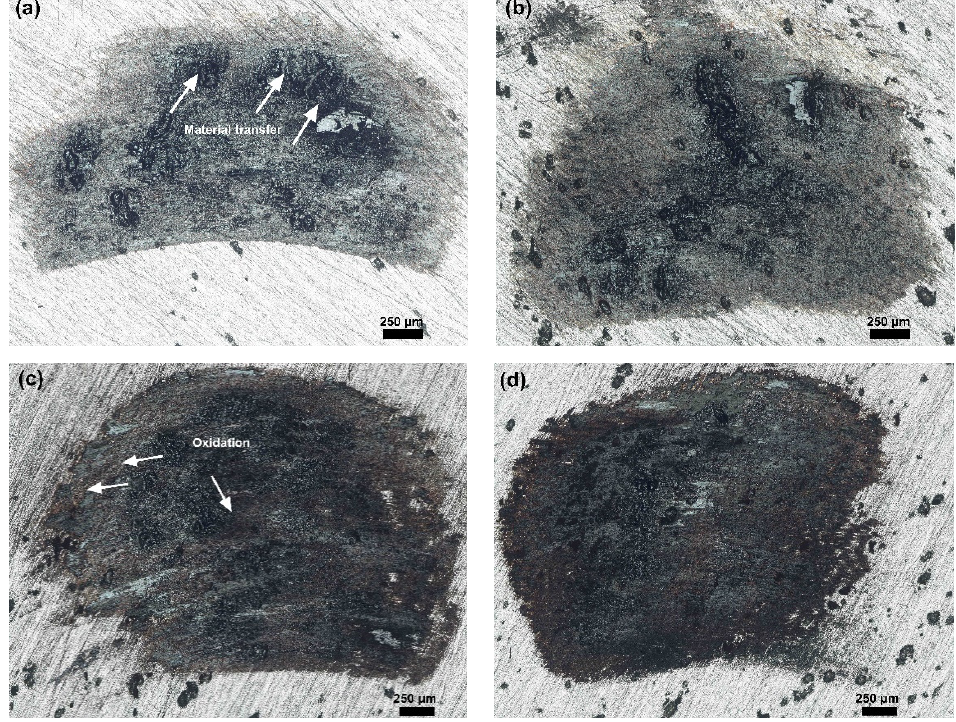
Figure 7. Images of the fretting wear tracks of AM-Inconel 625 at ( a ) 40; ( b ) 62; ( c ) 84 and ( d ) 106 N.